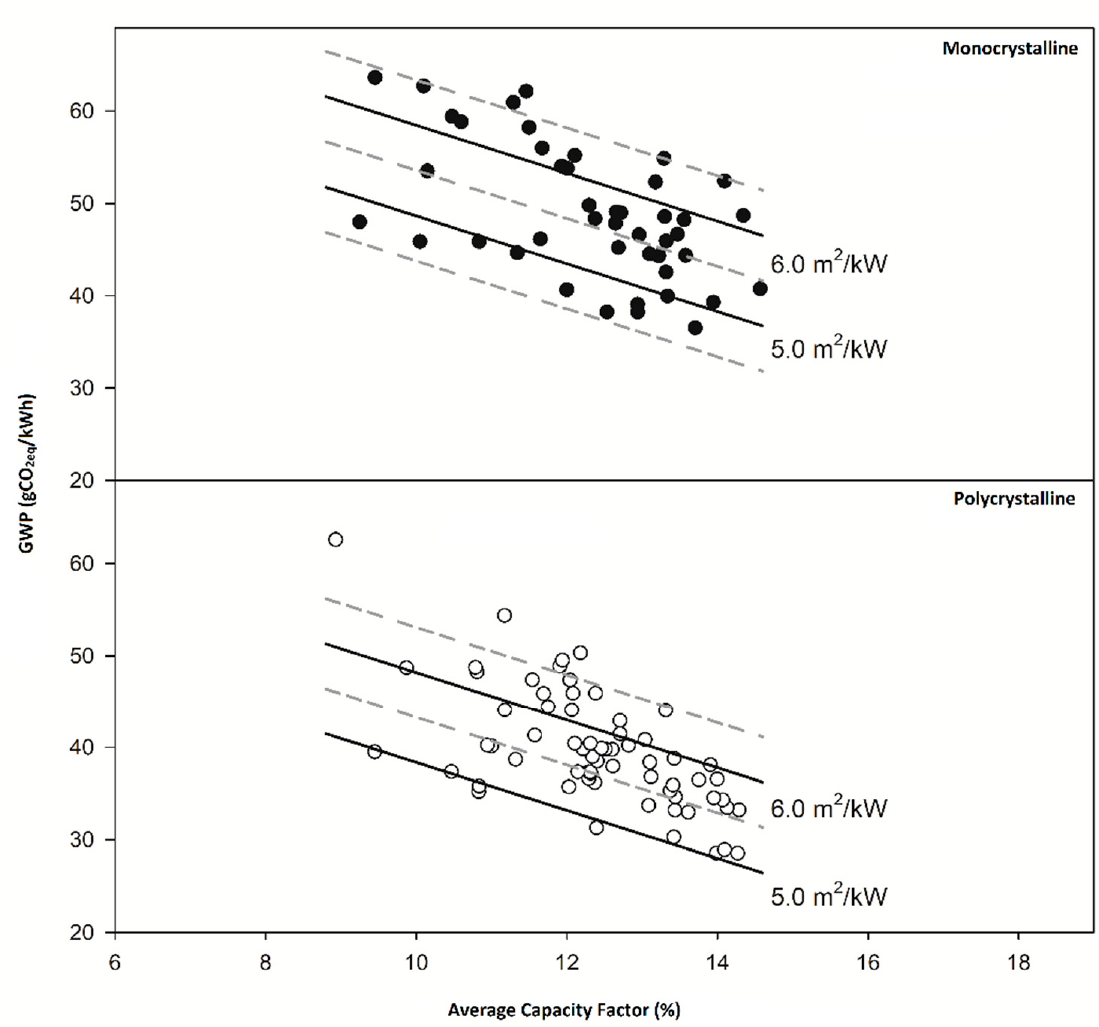
Figure 5. Change in Global Warming Potential ( GWP ) for polycrystalline and monocrystalline solar panels as a function of average capacity factor and area power ratio.